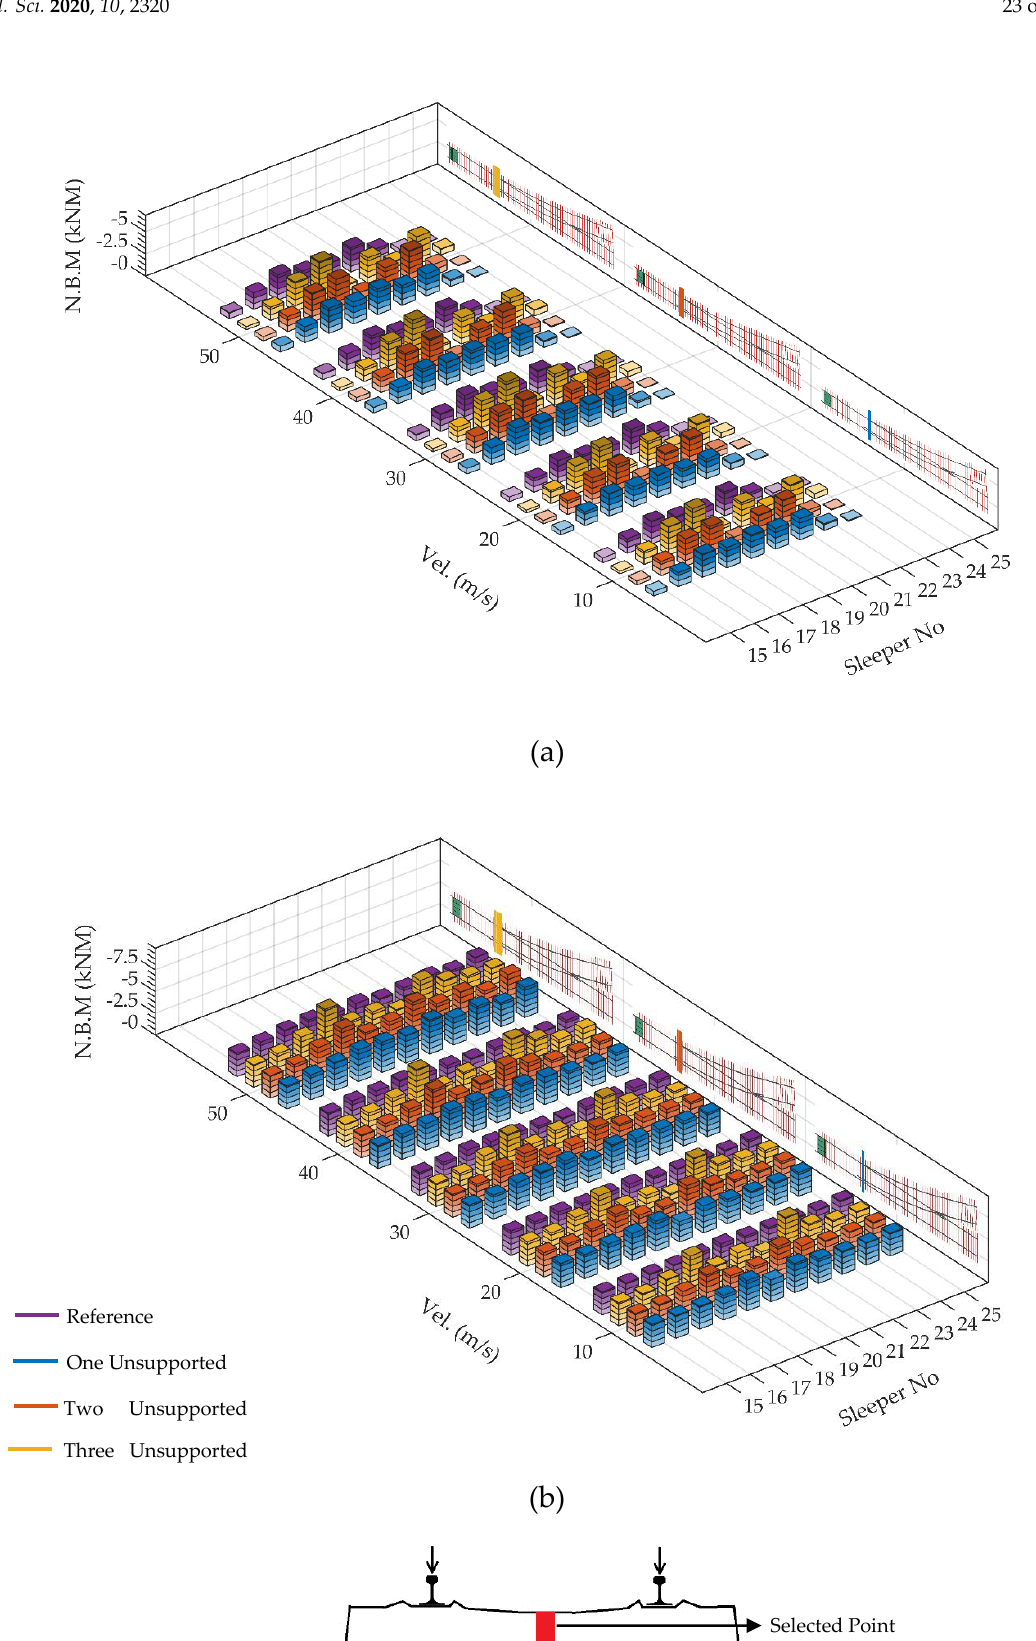
Figure 17. The distribution of negative bending moments over the bearers when unsupported bearers exist under switchblades: ( a ) at particular time when the front wheel is on the bearer with number 20; ( b ) when maximum occurs at each bearer.